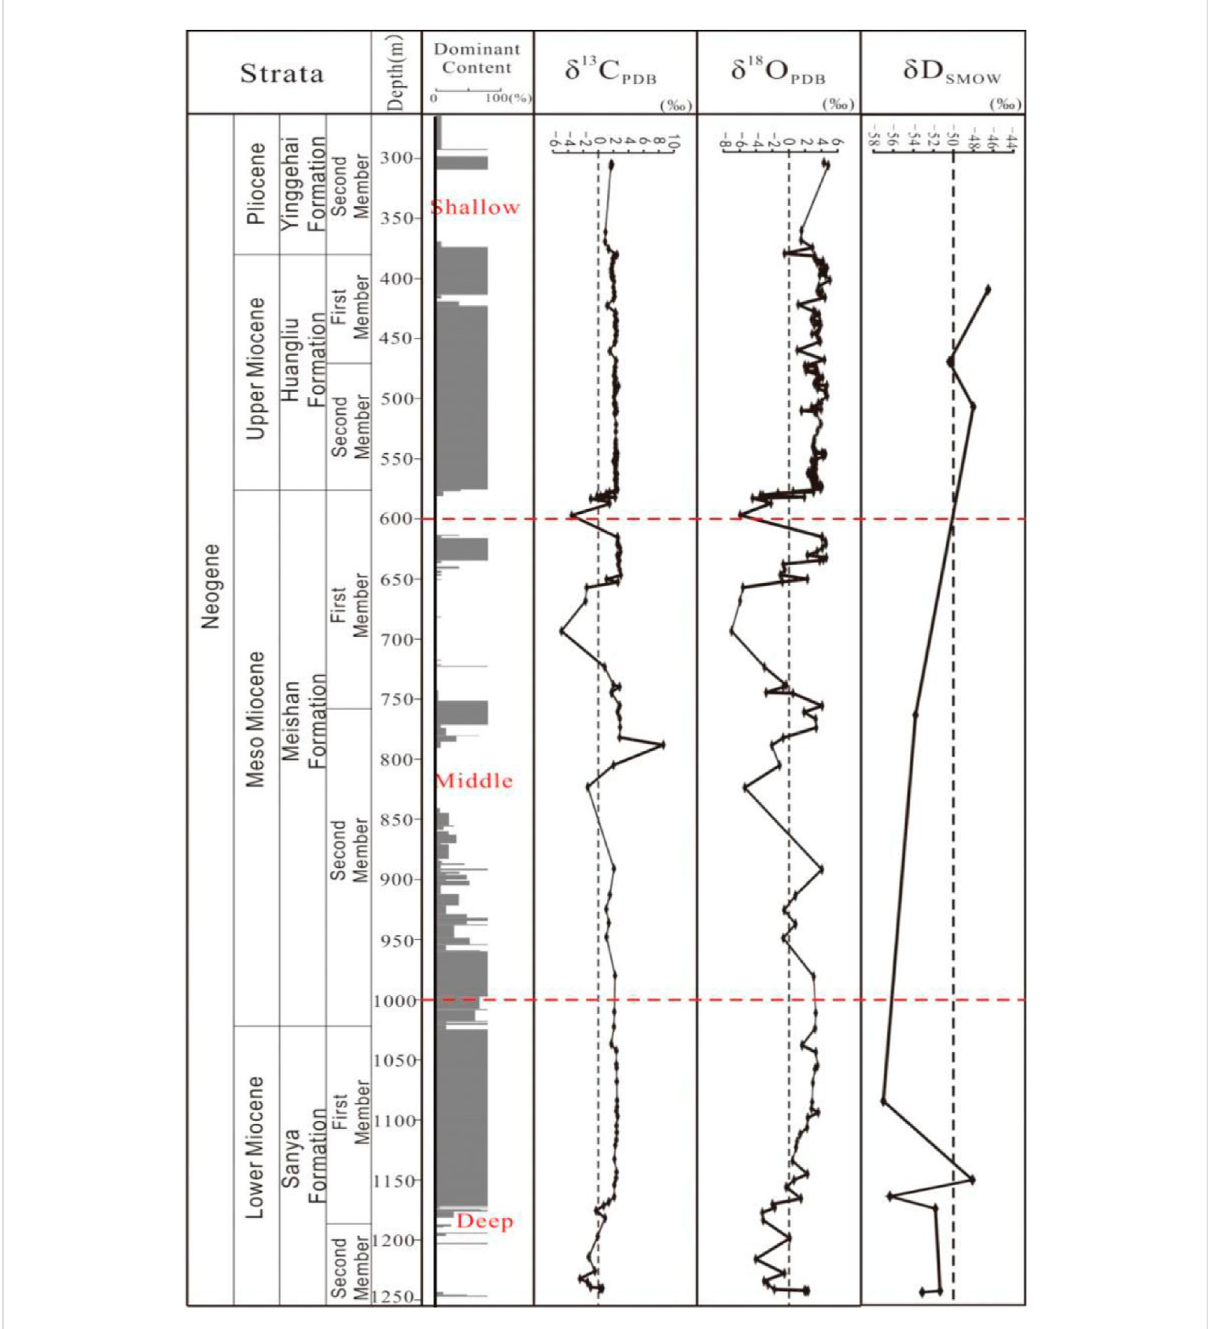
optical characteristics of them are similar. In the second member of the Sanya Formation, the saddle dolomites with medium coarse crystal are more common, and the crystallization degree of crystals will gradually increase with the increase of buried